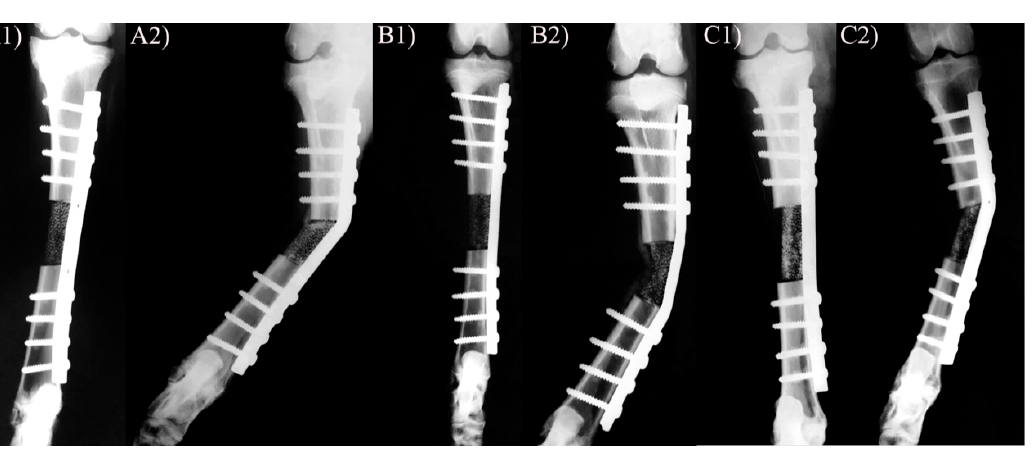
Figure 3. X-ray of three sheep tibiae representative of the CONTROL group 20 days after surgery. For each animal, two images are shown: the one on the left corresponds to a frontal plane in the immediately postoperative CONTROL ( A1 , B1 , C1 ) and the one the right to an x-ray taken after 20 days ( A2 , B2 , C3 ). Note the failure of the implant, with bending of the plate and medial deviation of the tibia.